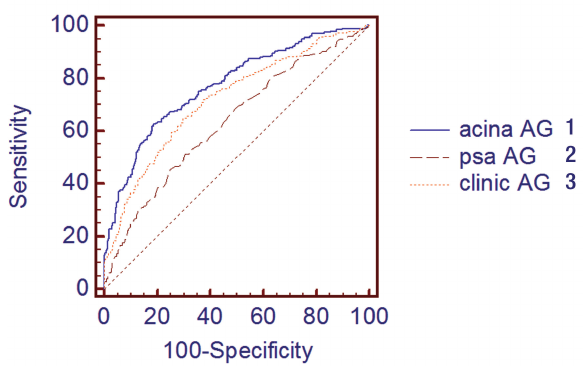
Figure 3 - ROC for all grades (AG) of cancer. Comparing acinar ratio (Prostatocrit) model with clinic model and PSA alone